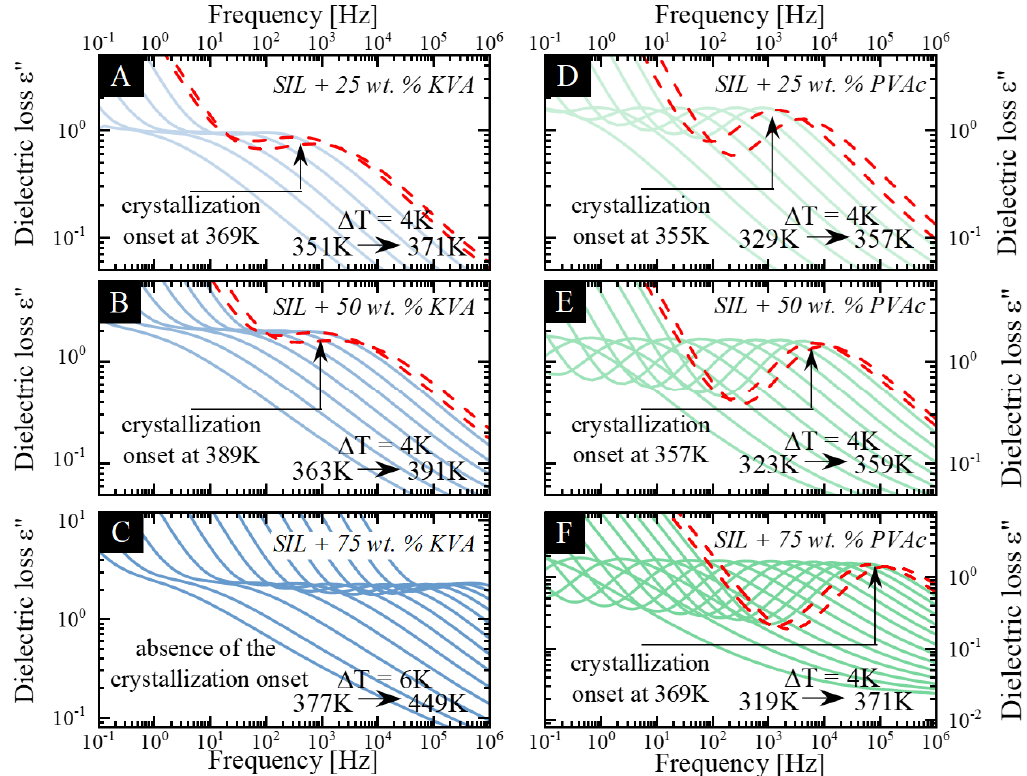
Figure 3. Dielectric spectra obtained during non-isothermal measurements. ( A – C ) presents the SIL + 25% KVA, SIL + 50% KVA and SIL + 75% KVA, respectively. ( D – F ) presents the SIL + 25% PVAc, SIL + 50% PVAc and SIL + 75% PVAc, respectively. Red dashed lines correspond to the recrystallization process.